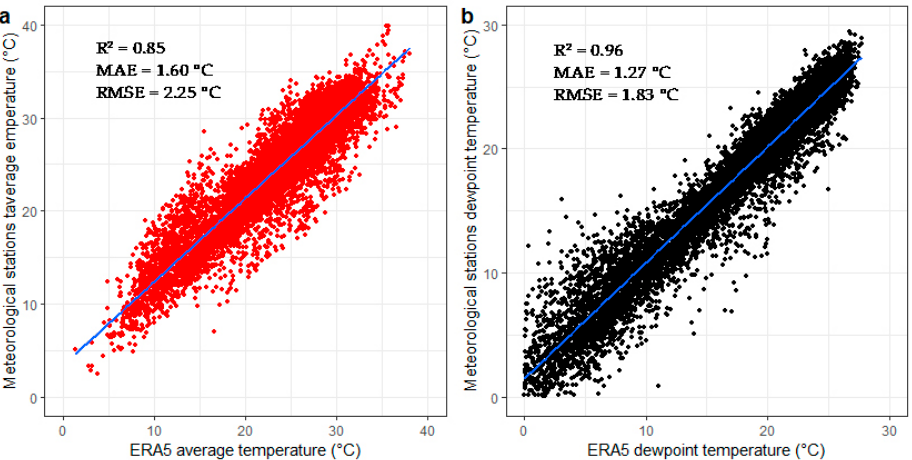
Figure 2. Correlation of ( a ) average temperature and ( b ) dewpoint temperature between the meteorological station data and ERA-5 atmospheric reanalysis data.